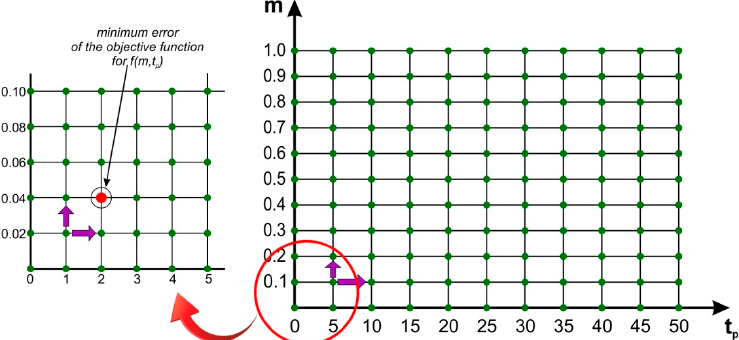
Figure 3. Schema of the exhaustive search method.